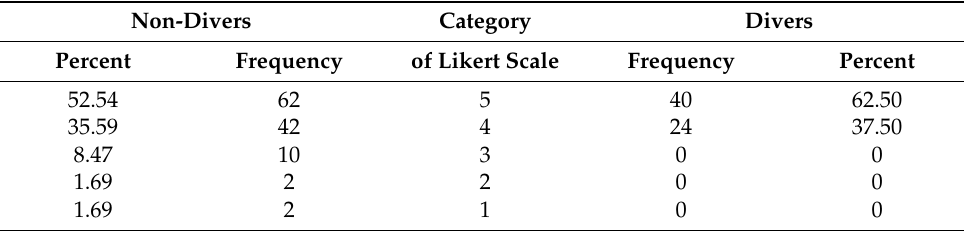
Table 8. Scuba diving impact on the improvement of the movement ability.